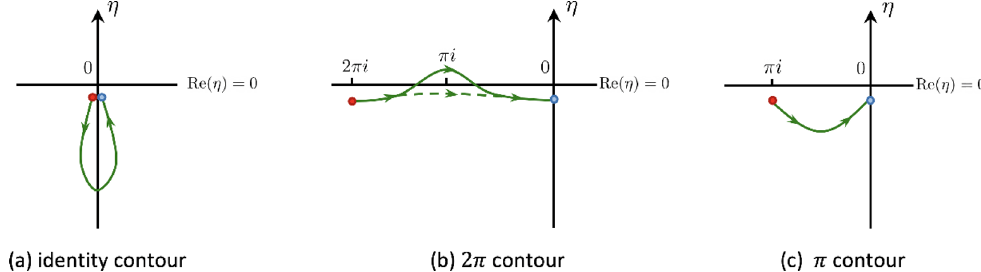
Figure 20 . Three contours that we consider, the red circle is the bra and the blue circle the ket. We describe them in the η coordinates and real values of η correspond to the vertical axis. (a) The identity contour, we simply go back in time and join the bra and the ket. It does not matter how far back in time we go. (b) The 2 π contour with the Milne metric (6.4). Now we have a non-trivial displacement in imaginary time, which will lead to a thermal state for the CFT. Both the solid line and dashed lines contours are equivalent for conformal matter. We suspect that the solid line contour gives the usual Hartle Hawking state also for any massive field. (c) The π contour, also for the Milne metric (6.4). It has a shorter displacement in the imaginary direction.